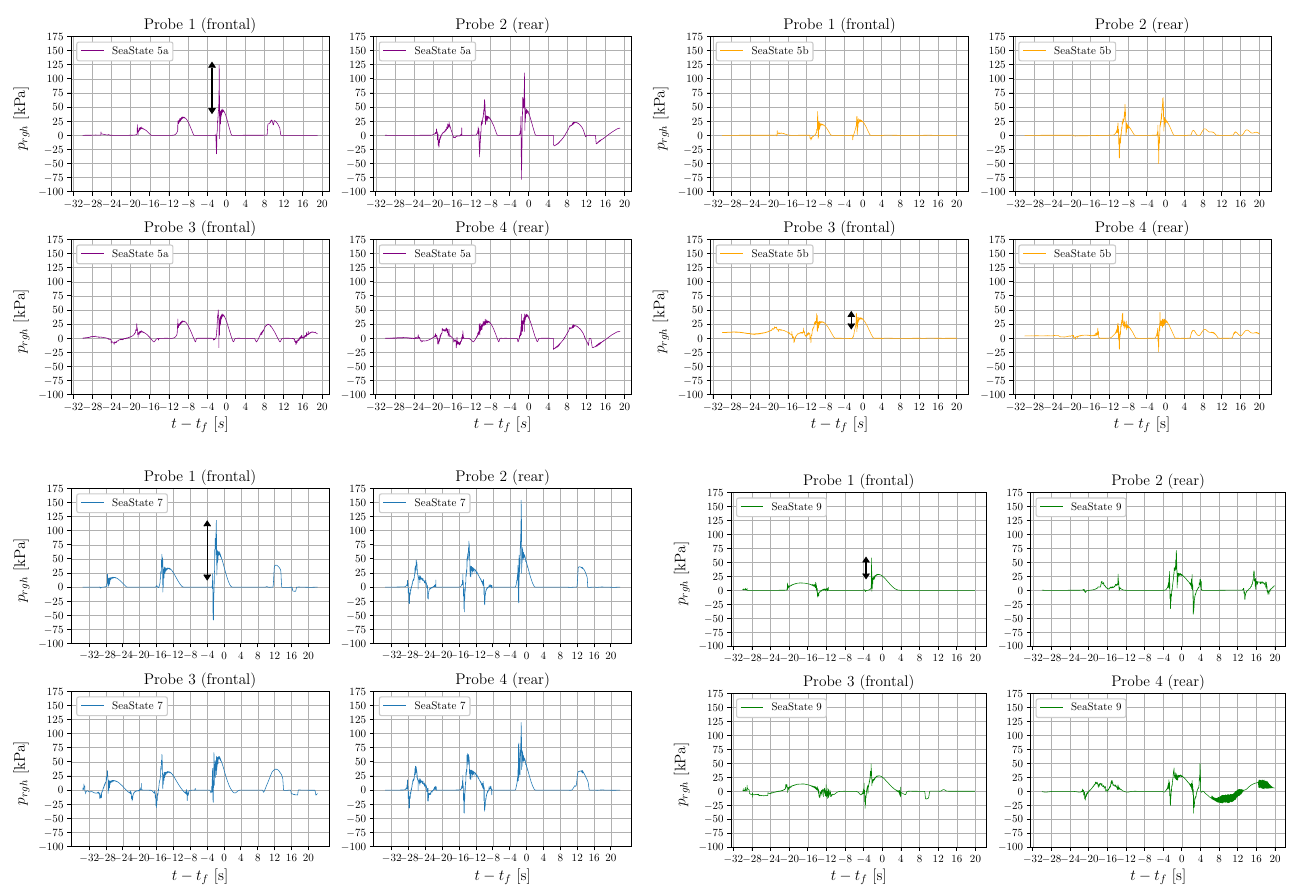
Figure 19. Pressure probes are mounted on the frontal and back part of the buoy. Probe 1 (frontal) and Probe 2 (rear) are located 0.24 m above SWL, whereas Probe 3 (frontal) and Probe 4 (rear) are located 0.97 m below the SWL. Time series of the pressure measured in each one probe is presented for sea states 5a (purple), 5b (orange), 7 (blue) and 9 (green). The black arrow indicates the slamming